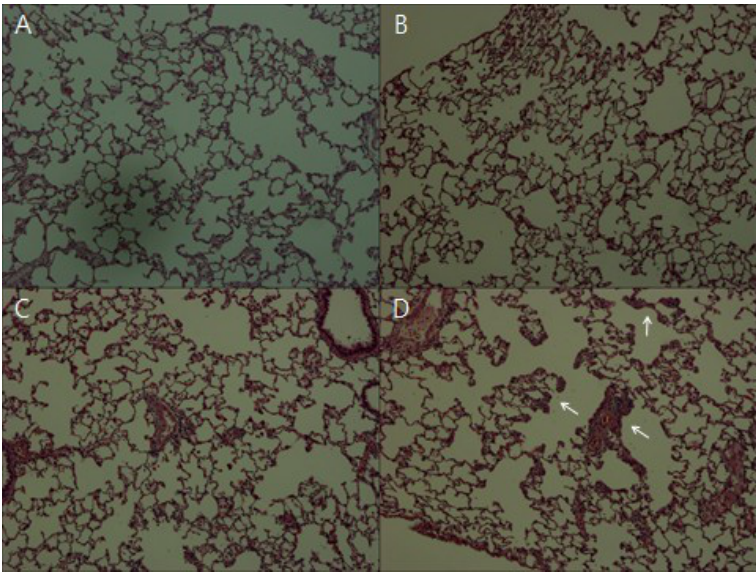
Figure 1. Histopathology of lungs from male rats exposed to silver nanoparticles for 12 weeks: ( A ) control; ( B ) low dose; ( C ) middle dose; and ( D ) high dose. Arrows indicate lesions with mixed cell infiltrate perivascular and chronic alveolar inflammation, including alveolaritis, granulomatous lesions, and alveolar wall thickening and alveolar macrophage accumulation.